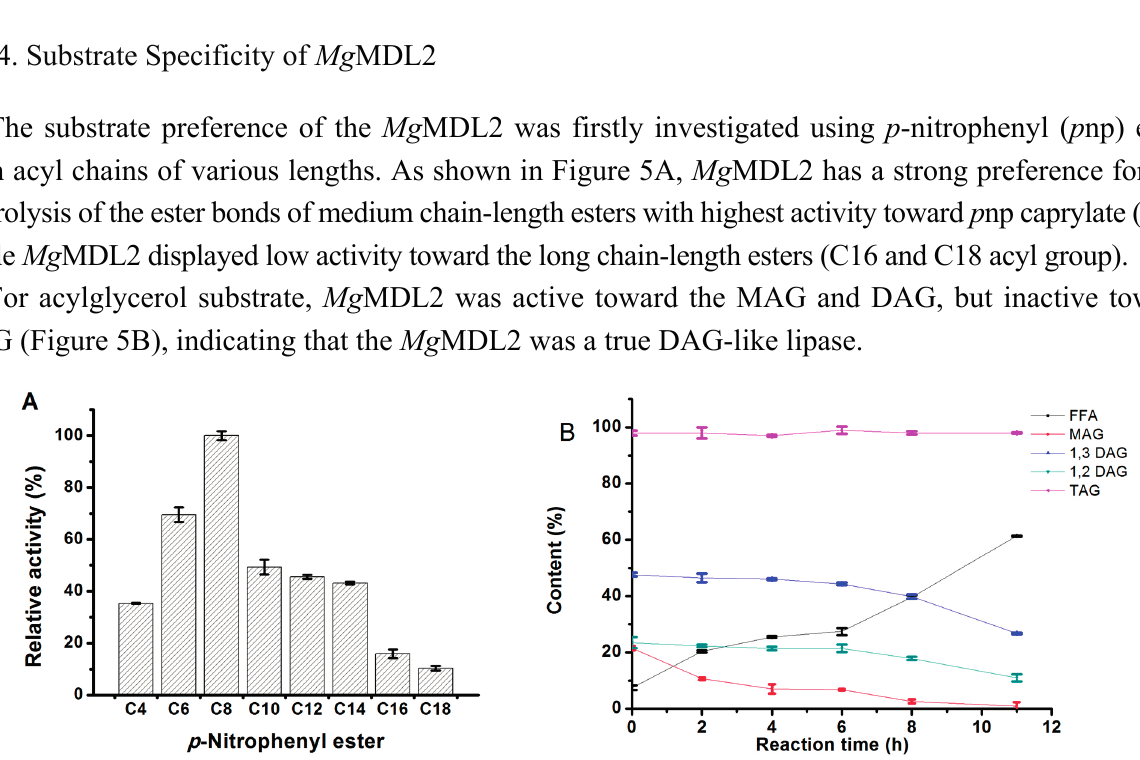
Figure 5. Determination of the substrate specificity of Mg MDL2. ( A ) Activities on each p np ester are expressed as the percentage of p np caprylate. Values are means ± S.D. from three independent experiments; ( B ) Time course of hydrolysis of acylglycerols by Mg MDL2. The hydrolysis reaction were performed using DAG-rich oil (23.47% of 1,2-DAG, 47.60% of 1,3-DAG, 21.51% of MAG and 7.42% of FFA) or TAG (camellia oil, 98%) as substrate. The reaction products contents were analyzed by HPLC and showed in same